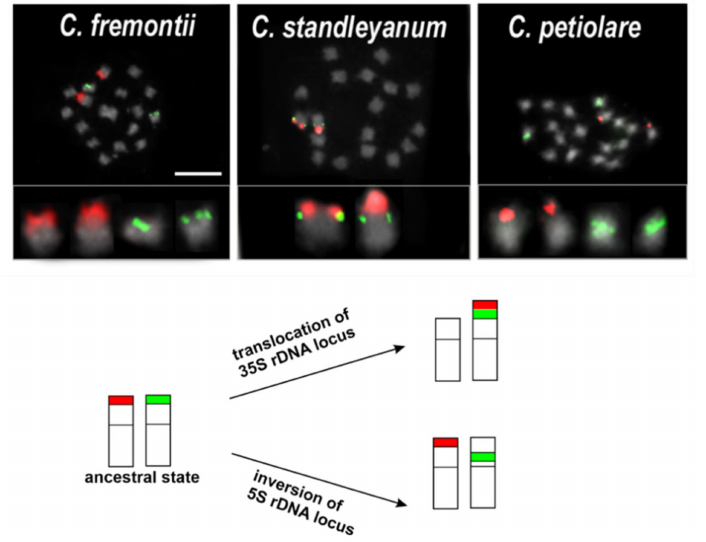
Figure 2. Karyotypes representing each variant of the rDNA loci distribution in the diploid Chenopodium species with genome A based on [89,108]. The ancestral state that was inferred for this clade was one locus of each 35S (red fluorescence) and 5S rDNA (green fluorescence) locus placed in two different chromosomes in a subterminal position like in C. fremontii . The loci pattern observed in C. standleyanum might be explained by the translocation of the 35S rDNA locus to the chromosome with a 5S rDNA array located in a subterminal position, whereas a plausible explanation for the rDNA patterns in C. petiolare (5S rDNA is in a more proximal position) seems to be an inversion of the part of the chromosome arm with subterminally located 5S rDNA. Scale bar = 5 µ